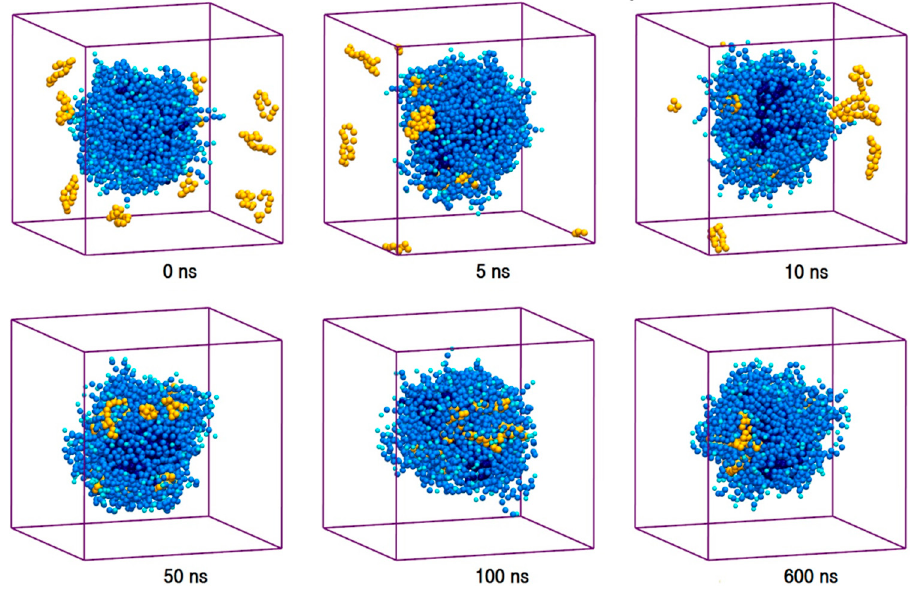
Figure 9. The trajectory snapshots of encapsulation of AmB molecules into P80 micelle at different simulation times (water particles have been removed for clarity).